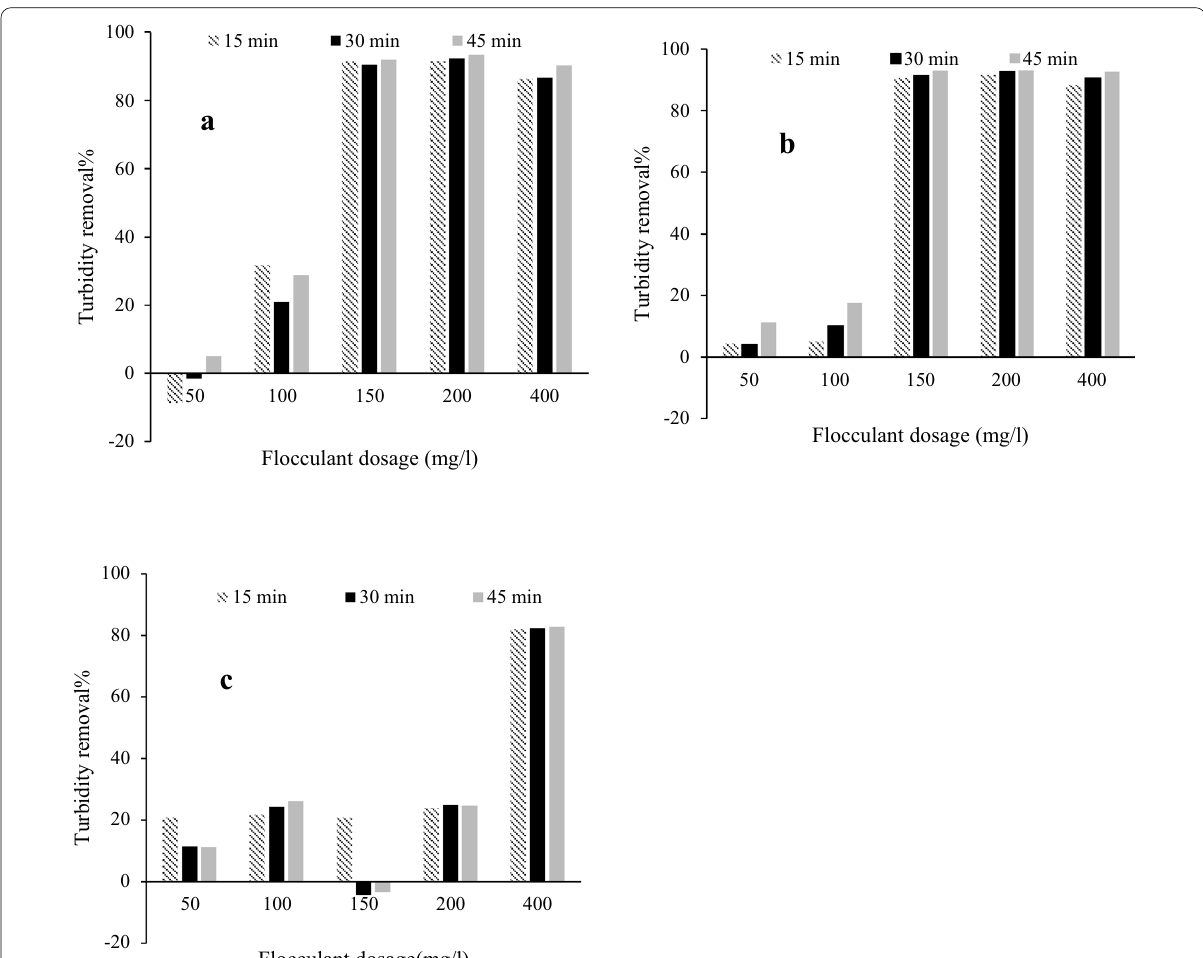
Fig. 6 The performance of the synthesized flocculant for turbidity removal from kaolin suspensions at the initial turbidity of 200 NTU considering different settling times at a pH 6, b pH 7, and c pH